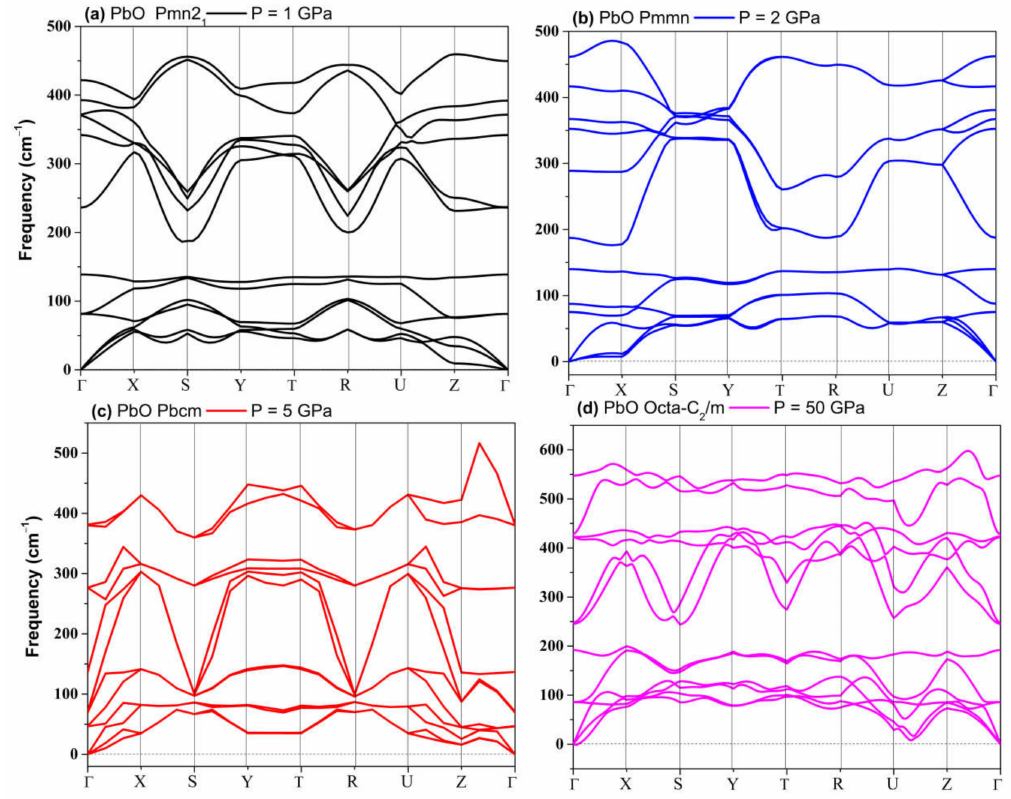
Figure 9. Phonon dispersion of phases of PbO: ( a ) Pmn2 1 ; ( b ) Pmmn ; ( c ) Pbcm ; ( d ) Octahedral monoclinic C 2 /m